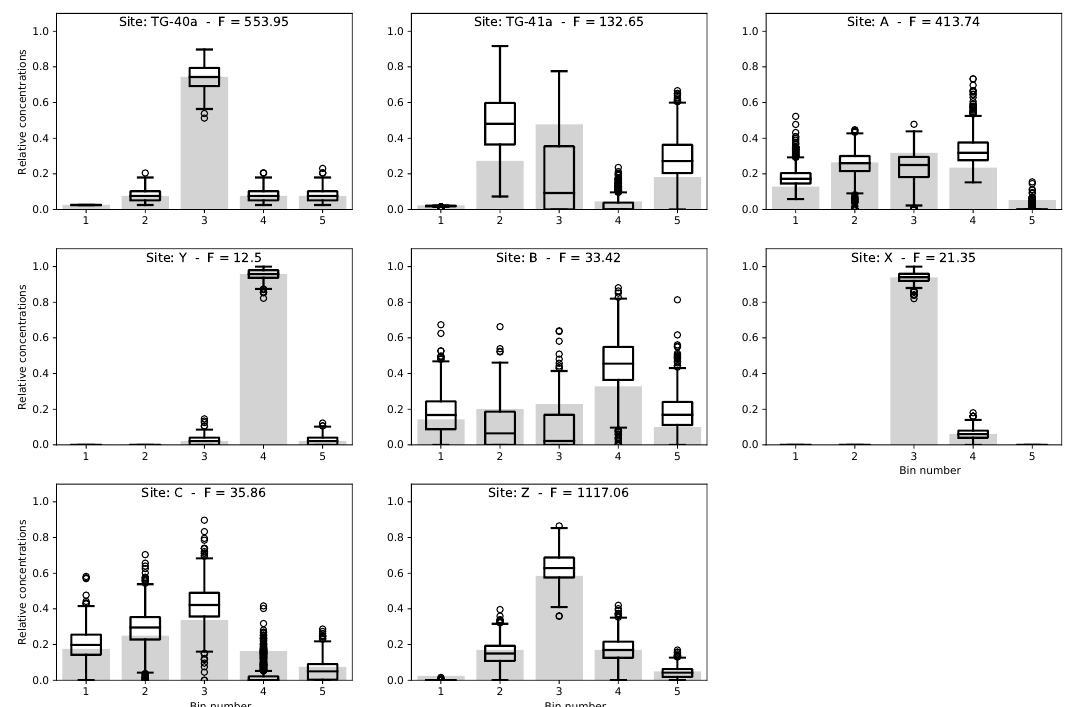
Figure 8. Observed distributions of ages (light gray bars) in samples collected at sites shown in Fig. 6 on which the distributions of predicted surface age distributions have been superimposed for each site. For each distribution, the box extends from the lower to upper quartile values, the line corresponds to the median value, and whiskers extend from the box to show the full range, excluding outliers. Outliers are indicated by small circles past the end of the